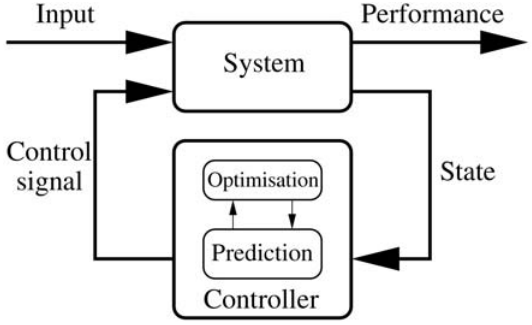
Figure 6. Working principle of